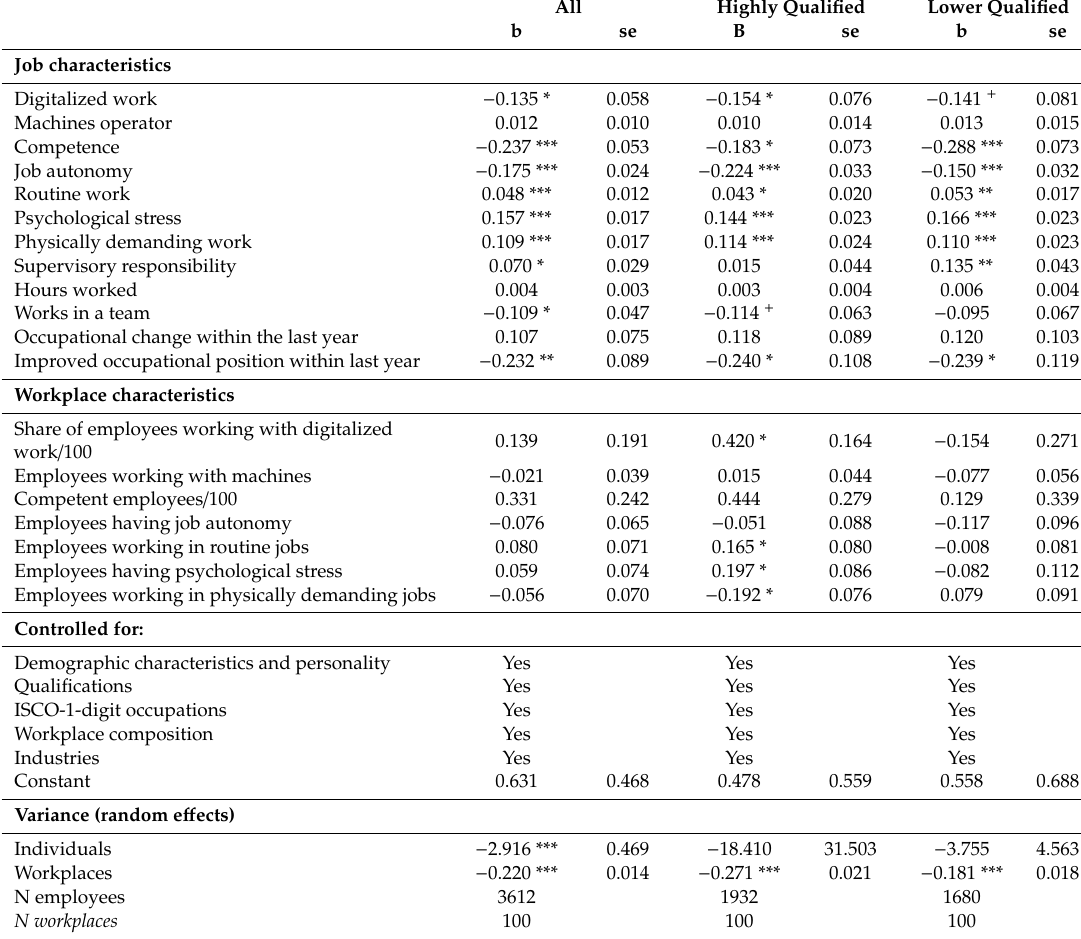
Table 3. Influence of digitalized work and other job characteristics at the individual and workplace level on bullying from supervisors (workplace level random e ff ects